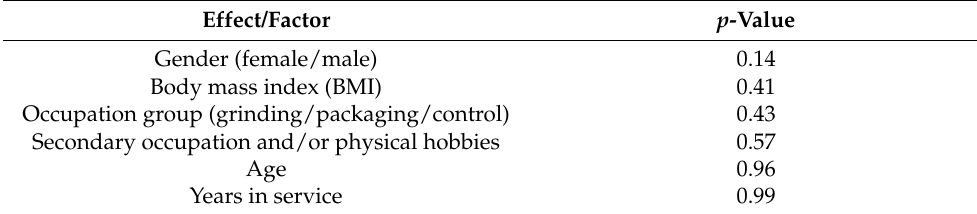
Table 5. Results of the multiple analysis for the endpoint WMSDs.